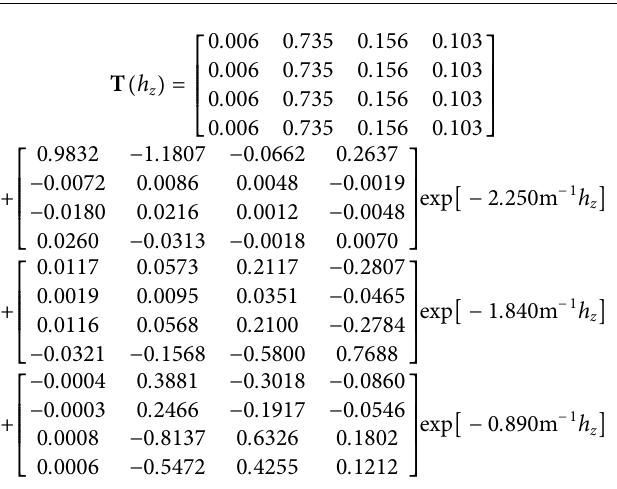
FIGURE 2 | Vertical direction transition probability measurements (circles) and Markov chain model